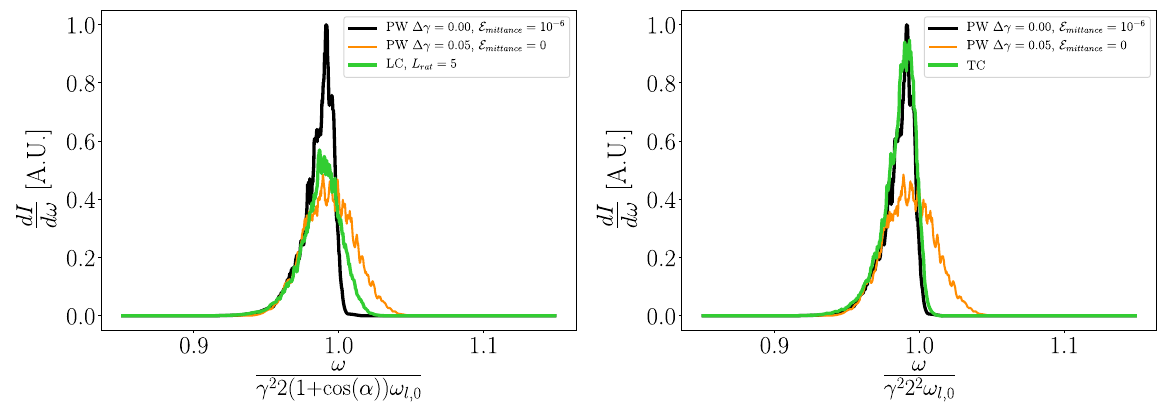
¼ 1 , 10 γ max ¼ 0 . 05 and E ¼ 0 ½ mm mrad (cid:2) . The frequency γ mittance ¼ 0 . 05 . Left: LC with collision angle γ